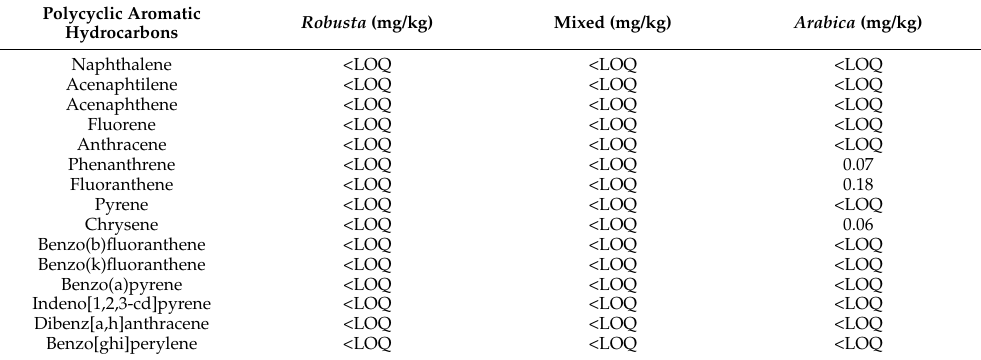
Table 2. Concentrations (mg/kg) of polycyclic aromatic hydrocarbons (PAHs) in three classes